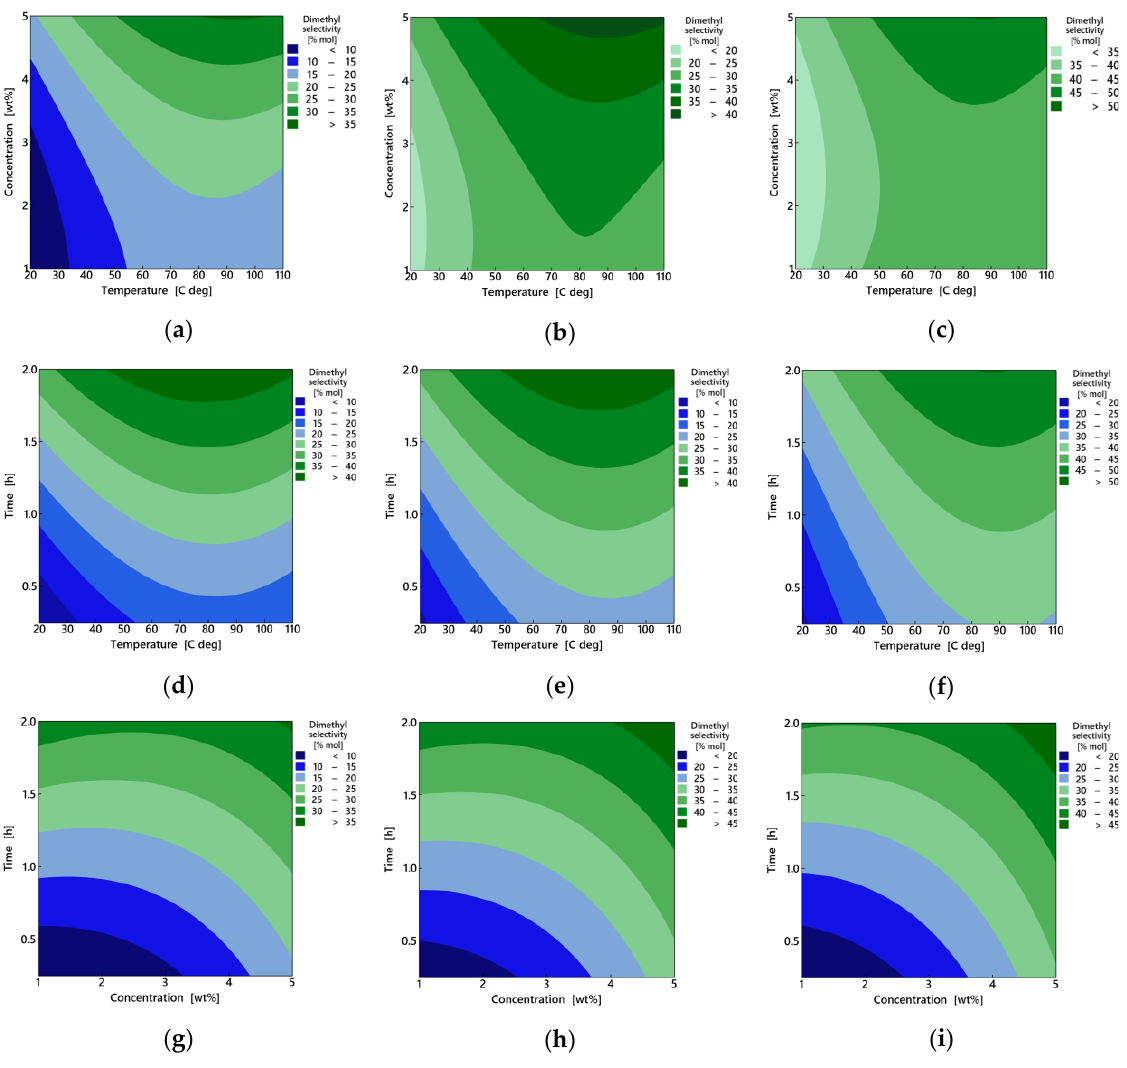
Figure 4. Contour plot of dimethyl selectivity at: time: ( a ) 0.25 h, ( b ) 1.125 h, and ( c ) 2 h, concentration: ( d ) 1 wt.%, ( e ) 3 wt.%, and ( f ) 5 wt.%, and temperature: ( g ) 20 °C, ( h ) 65 °C, and ( i ) 110 °C.